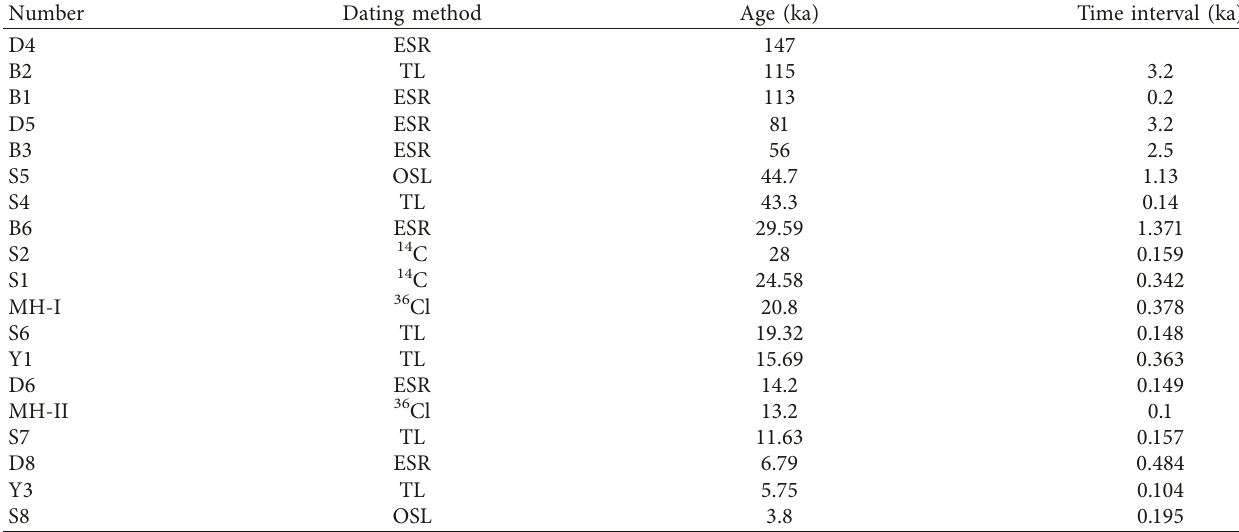
Table 2: The 19 paleo earthquakes identified after analysis and screening.